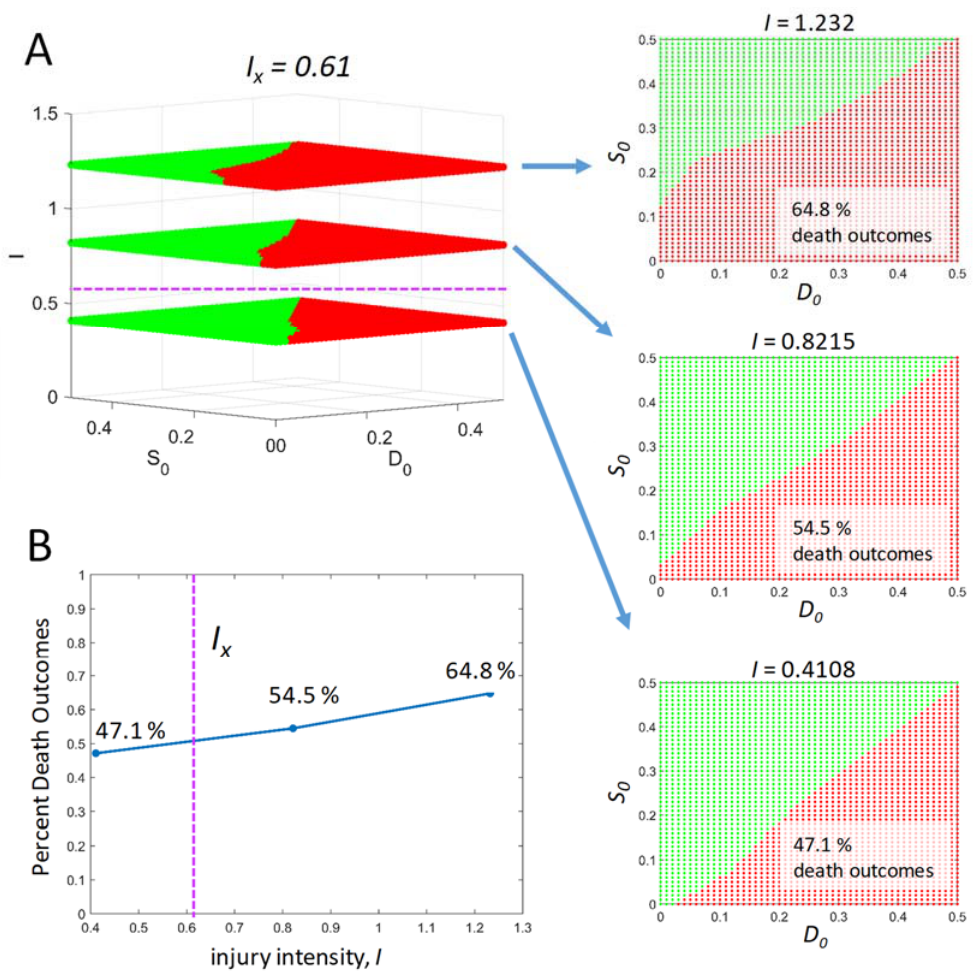
Figure 4. Initial condition outcome planes as a function of I . ( A ) Three outcome planes plotted vs. I . Arrows point to face-on views of each plane. ( B ) Percent death outcome for each of the three planes vs. I .